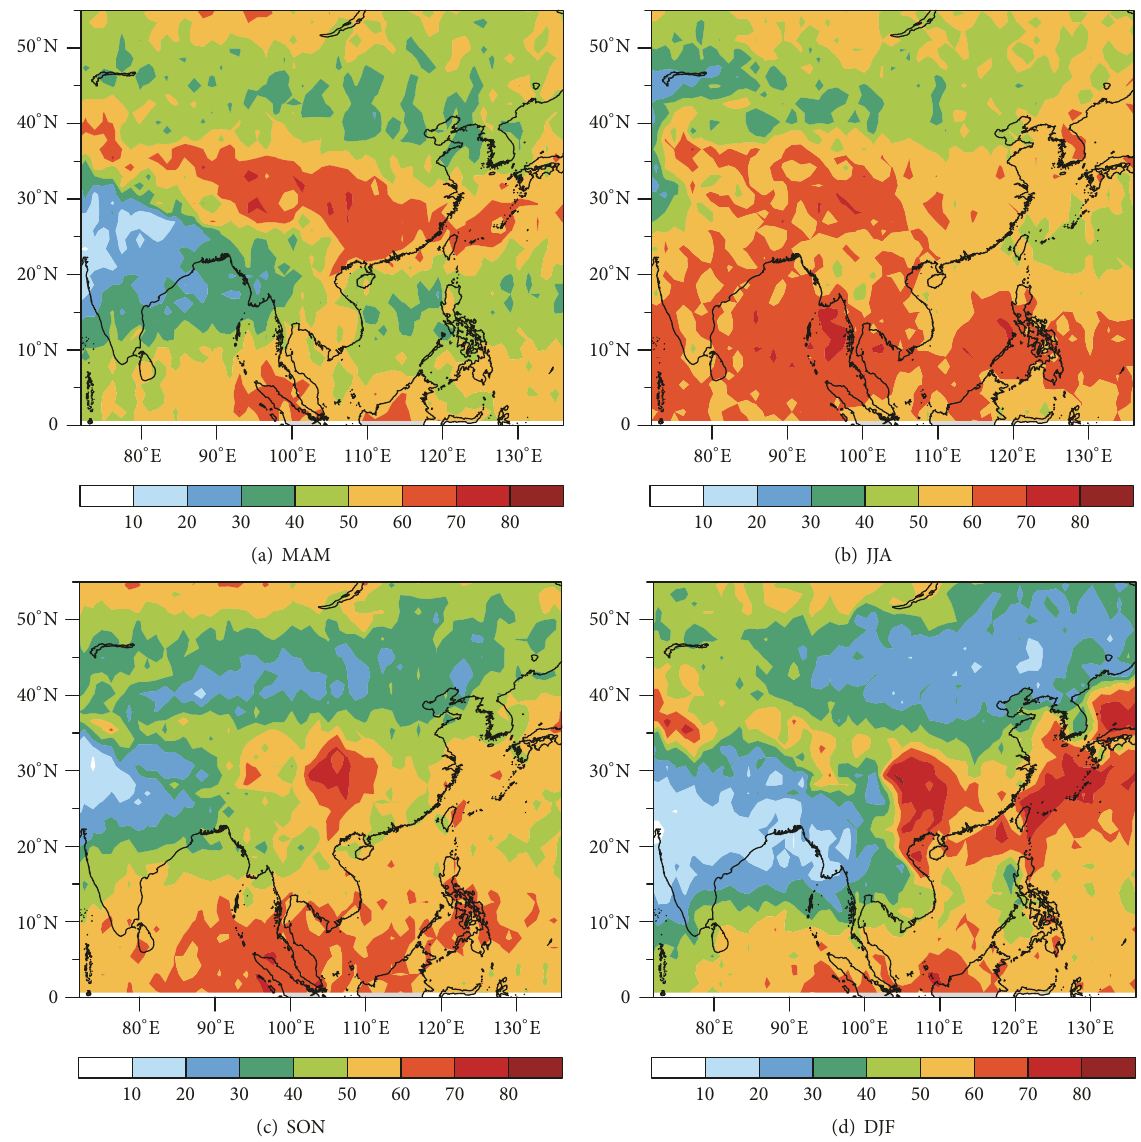
Figure 8: Contribution of single-layer clouds to total cloud occurrence in different seasons (MAM, JJA, SON, and DJF), %.